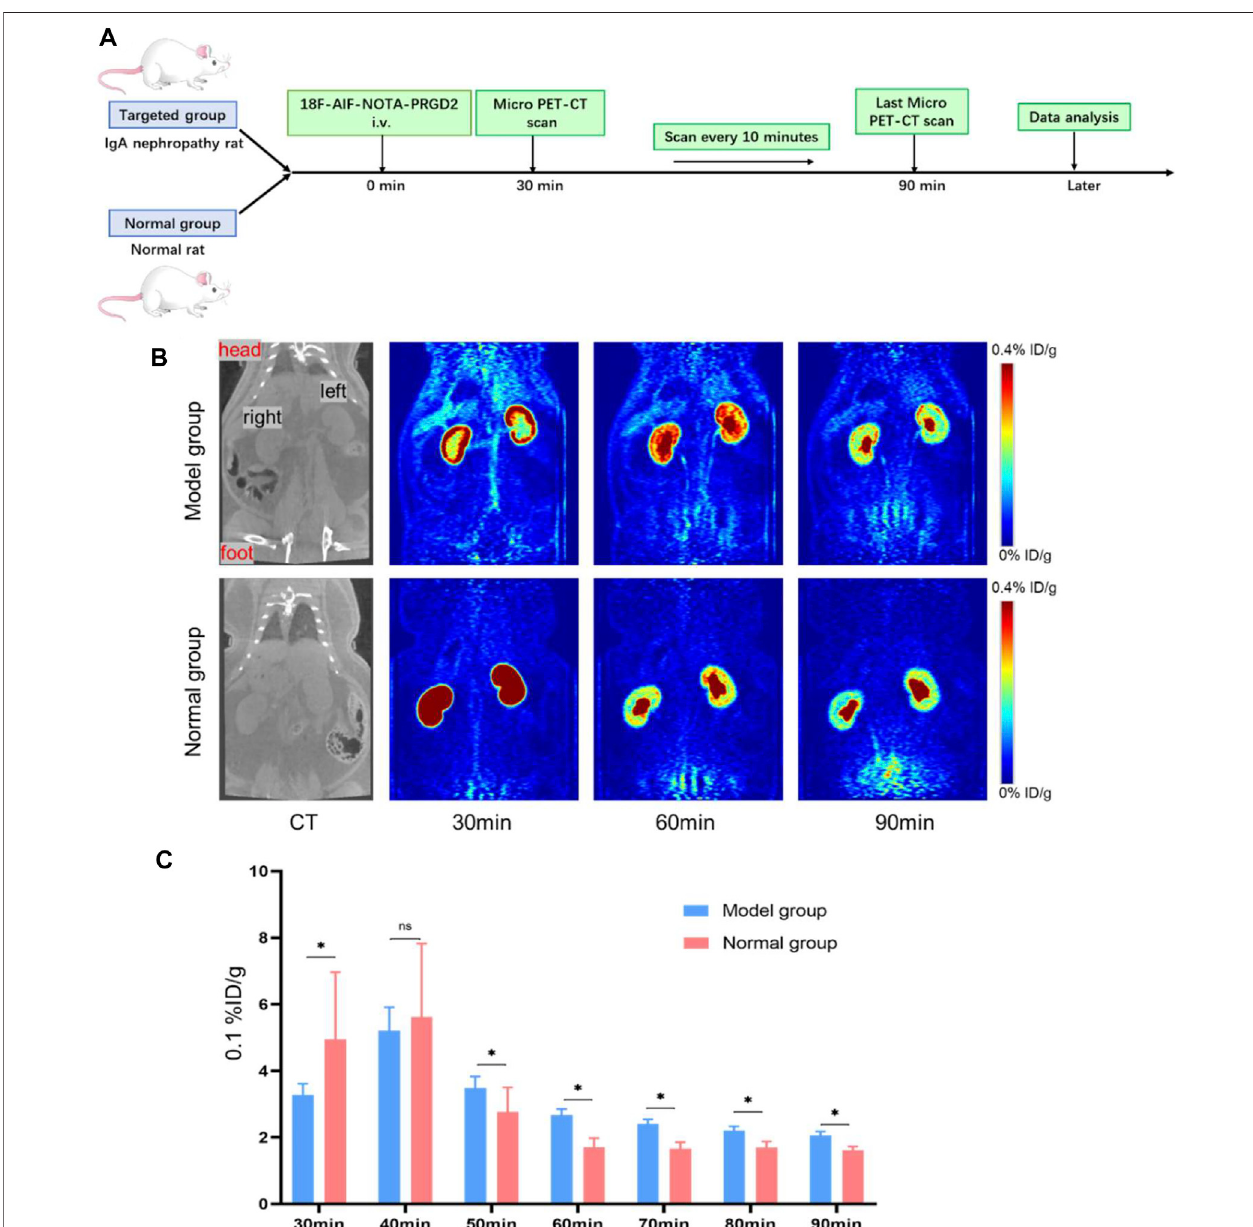
FIGURE 4 | The veri fi cation of the IgA nephropathy rat model in micro-PET images with 18 F-ALF-NOTA-PRGD2. (A) Experimental schematic to verify the IgA nephropathy rat model in micro-PET images. (B) Micro-PET images at different time points after the injection of 18 F-ALF-NOTA-PRGD2 for both groups. (C) The quantized value of radioactivity at the different time (* p <